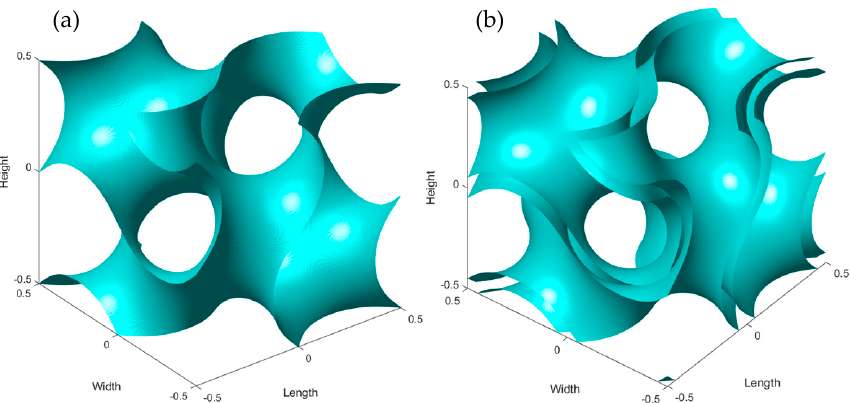
Figure 1. Minimal surface—gyroid: ( a ) isosurface with constant C = 0 (according to Formula (3) from Table 1); ( b ) isosurfaces spaced apart by the amount of +/ − C.